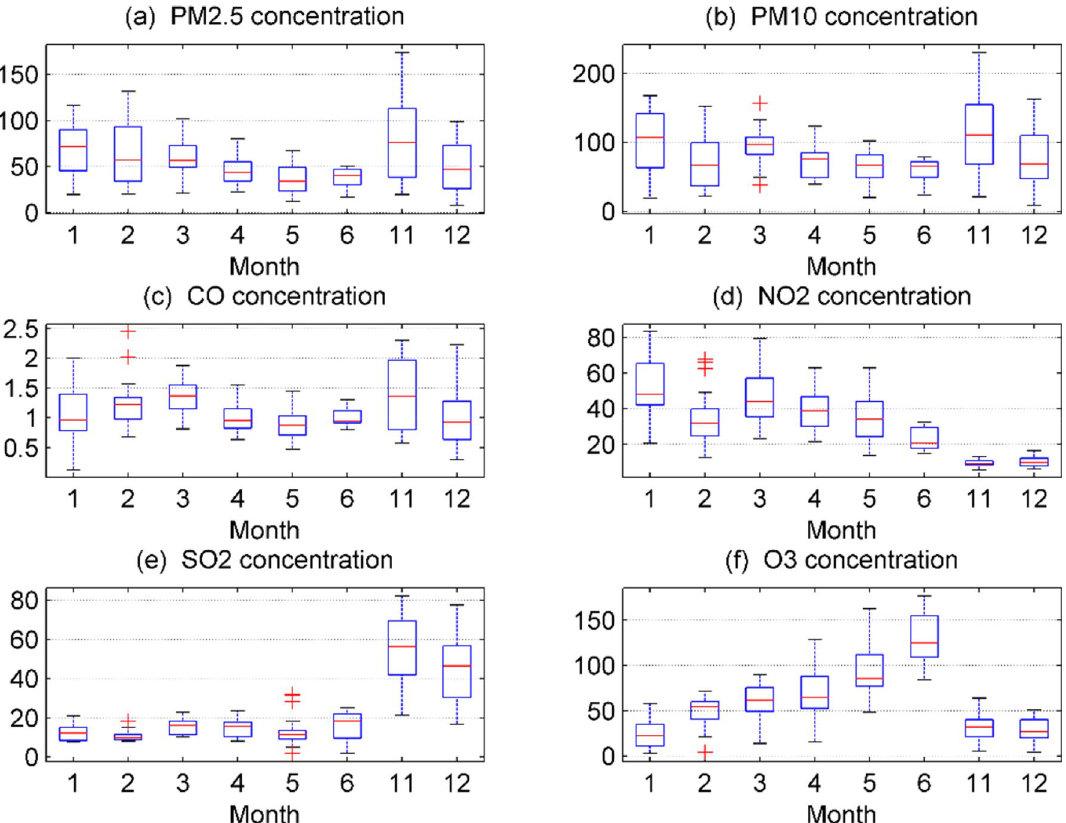
Figure 2. Comparison of monthly average data of six types of pollutants at national control points and self-built points. Figures are generated using Matlab (Version R2016a, https ://www.mat-hwork s.com/) (software).